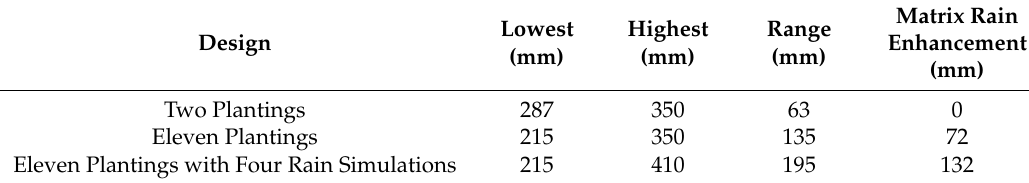
Figure 7. The study-rain (rain + simulated rain) for four plantings in 2016 and seven plantings in 2017. For each planting there are four simulated rain deciles (4 through 7). The treatments are designated as #D (decile number), P# (planting number), 16 or 17 (year). Table 3. Rain Outcomes shows an overview of the two years of the study. For brevity, the data shown is limited to the 4th decile of simulated rain all the planting dates.